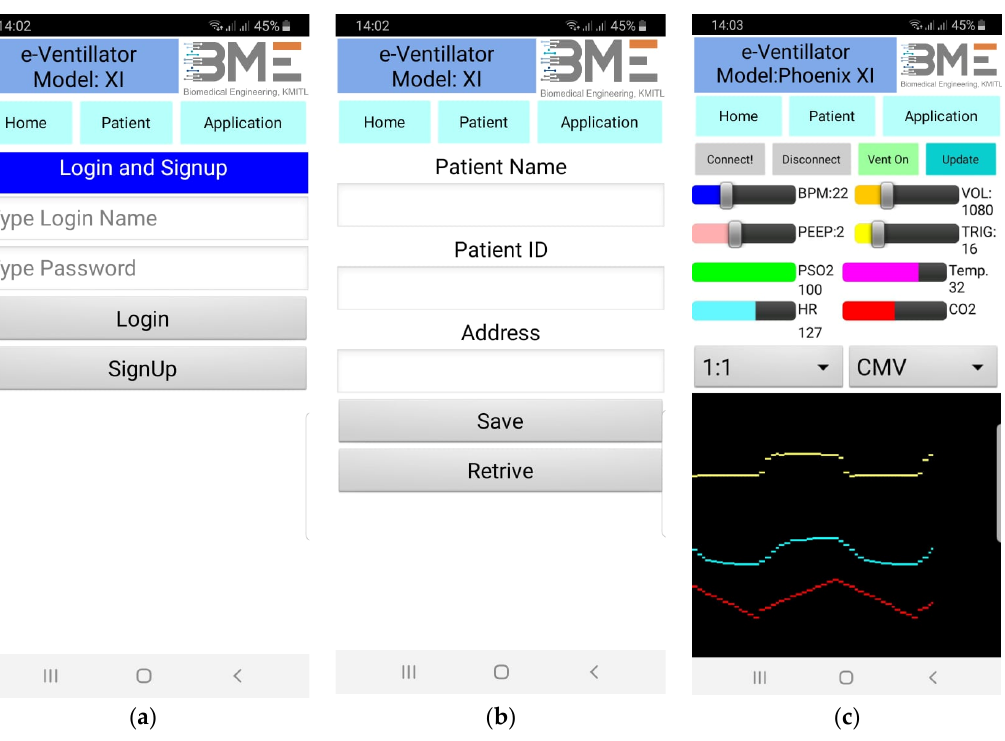
Figure 11. Designed web client page consists of three main parts which are numerical display for sensing parameter, graphs of parameters, and graphic user interface to control ventilation parameters.